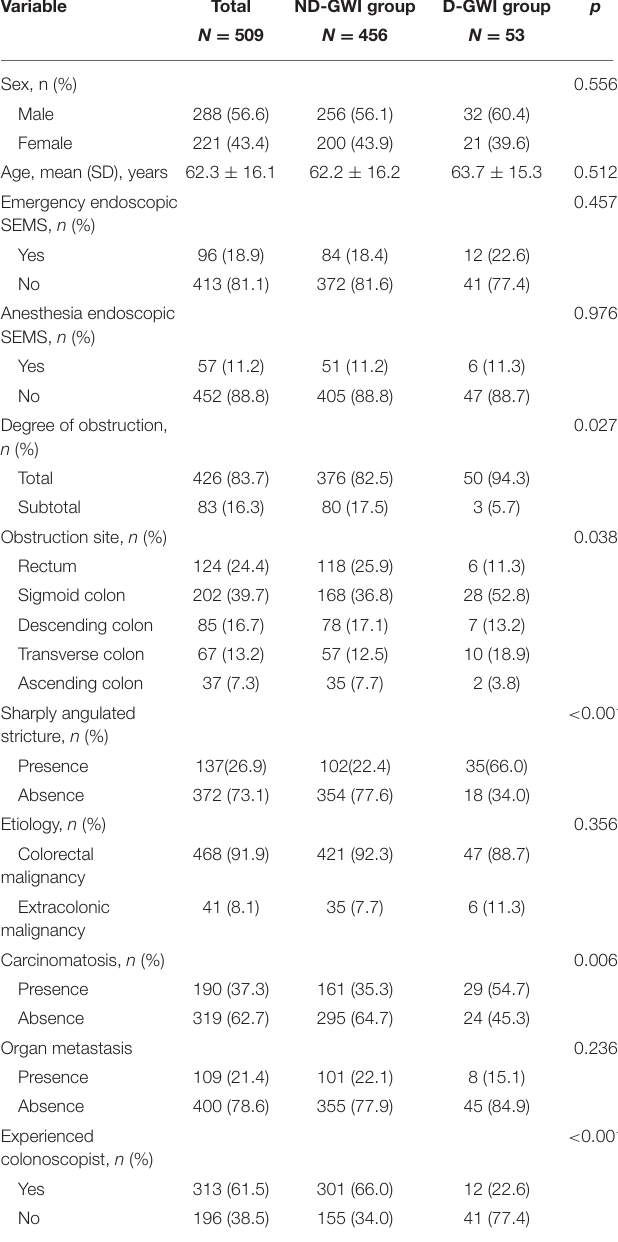
TABLE 1 | Baseline characteristics of patients with malignant colorectal